Question: Describe this figure in one sentence.
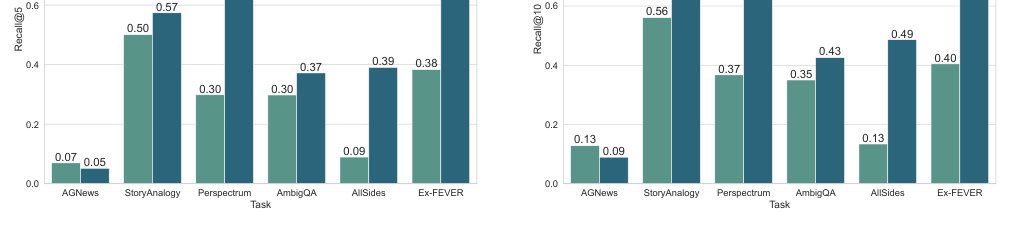
Answer: Retrieval performance (Recall@k, k=5,10) between queries with or without per- spectives attached. Per-task performance is the macro-average of all the retrievers.